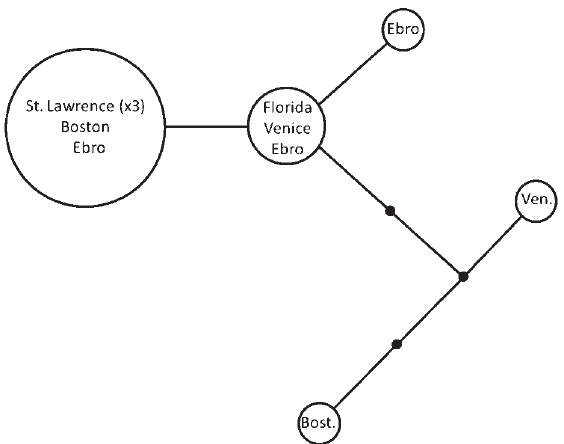
Fig . 3. – Haplotype network of eleven specimens of Dyspanopeus sayi from introduced Mediterranean as well as from native popula- tions. The network is based on 658 basepairs of the Cox1 mtDNA. Population localities are written within haplotypes (Ven., Venice Lagoon; Bost.,